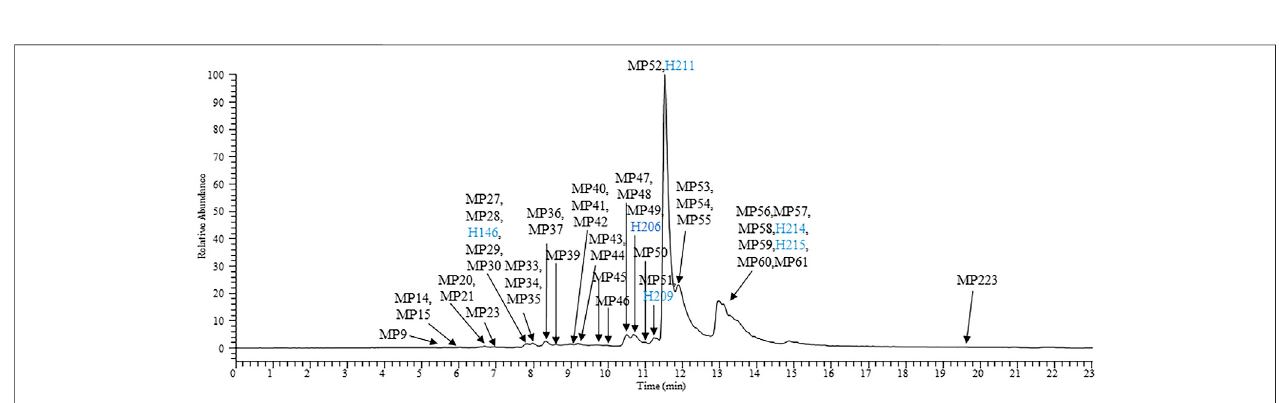
FIGURE 2 | High-resolution extracted ion chromatogram of the main exposed components of human plasma samples processed using the methanol protein precipitation method. Blue: prototype components of rhubarb.